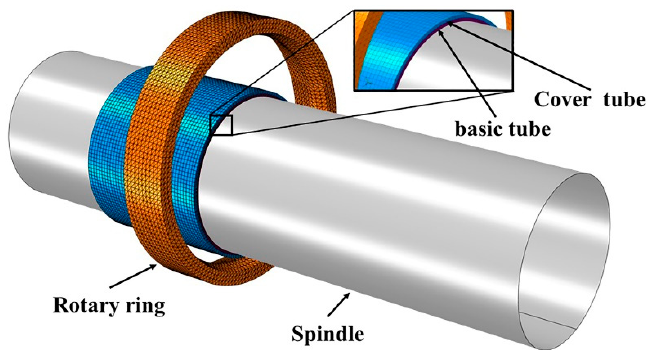
Figure 2. Finite element model of bimetallic tube rotary ring spinning.